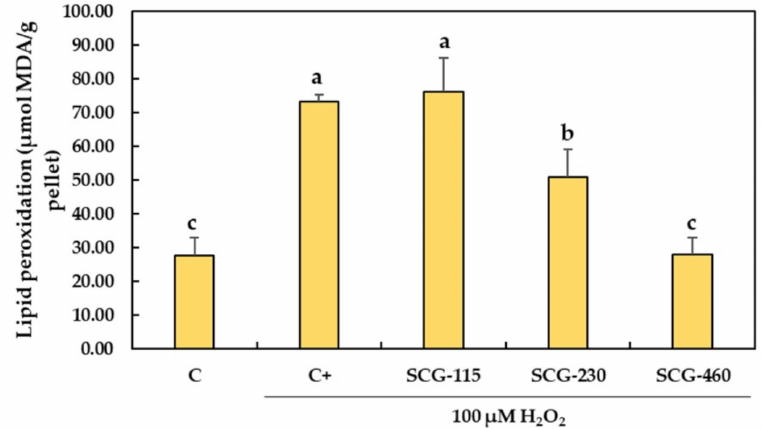
Figure 2. Effect of polyphenolic extracts from SCG on the lipid peroxidation in C. viridis brain cells under H 2 O 2 -induced oxidative stress. Cells were pretreated with the SCG extracts (115–460 µ g/mL) for 24 h and then incubated in the presence of 100 µ M H 2 O 2 for 1 h. C: control, non-treated cells; C+: cells treated with 100 µ M H 2 O 2 alone; SCG: cells pretreated with the spent coffee ground polyphenolic extracts at 115, 230 and 460 µ g/mL, and treated with 100 µ M H 2 O 2 . Data are presented as means ± SD ( n = 3). Different letters (a, b, c) indicate significant differences between the treatments ( p < 0.05).